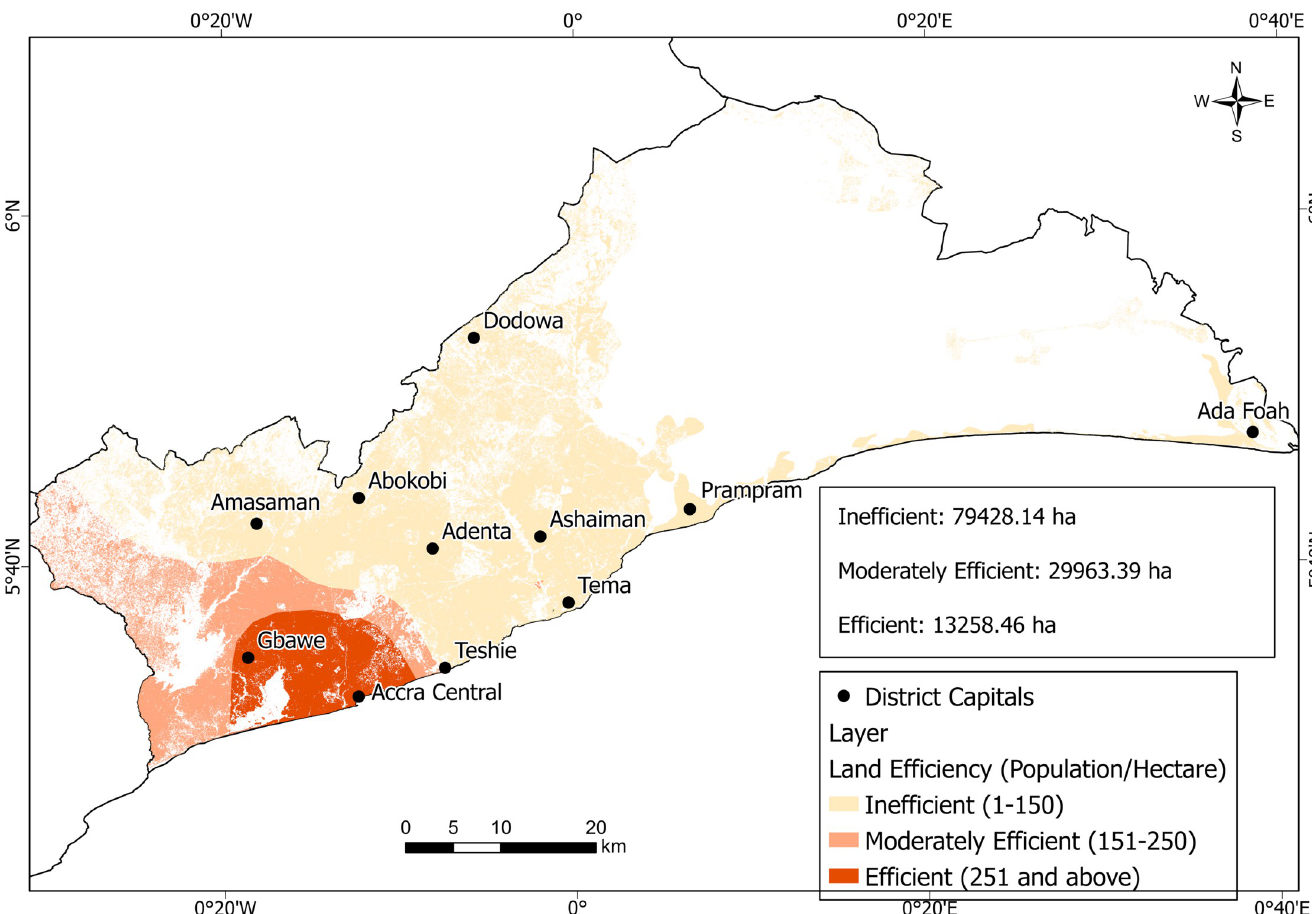
Fig 5. Land consumption in Greater Accra Region. Source: Authors construct with base map from [37].